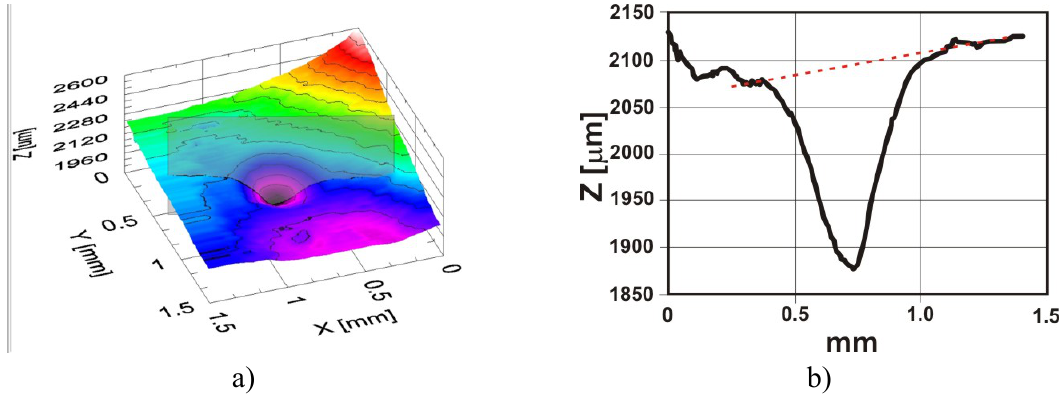
Figure 17. OCT analysis of Er:YAG ablation crater in varnish: a) recovery of shape; b) OCT measurement of the crater depth. Proper matching of laser